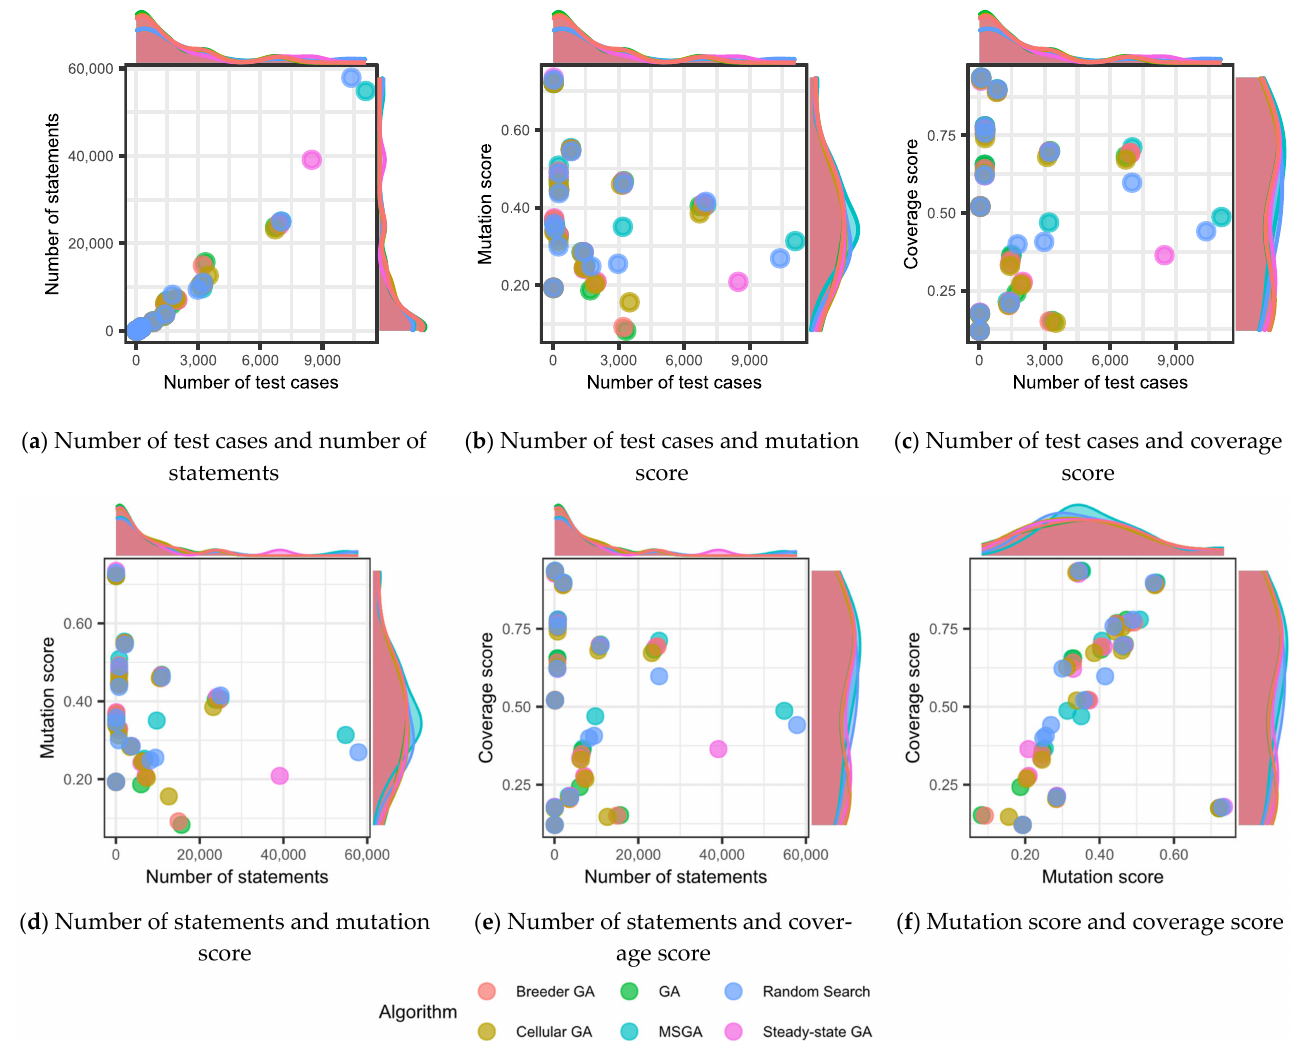
Figure 5. Correlation of pairs of output